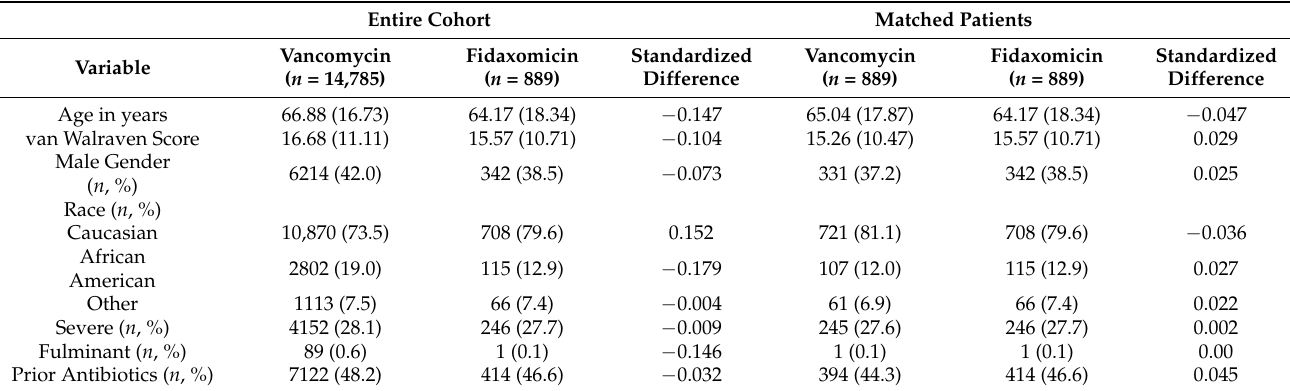
Table 1. Baseline characteristics (mean, standard devation unless otherwise